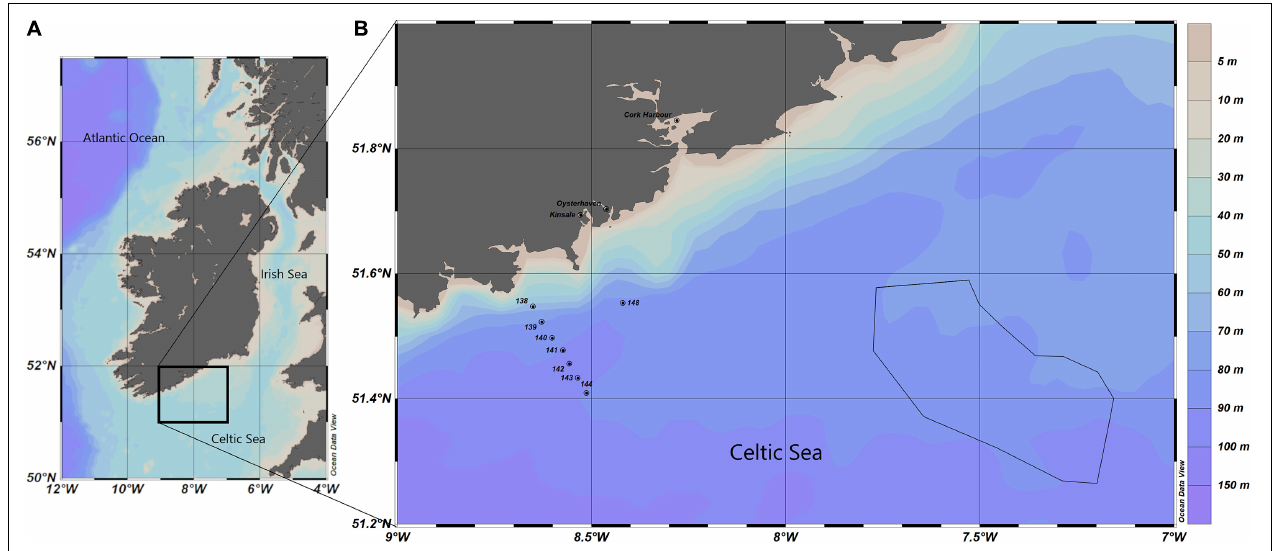
FIGURE 1 | (A) Map of study area in the Celtic Sea. (B) In situ sample locations are noted as points and the polygon location for the particle tracking model is outlined by the black line. Bathymetry is represented in metres.